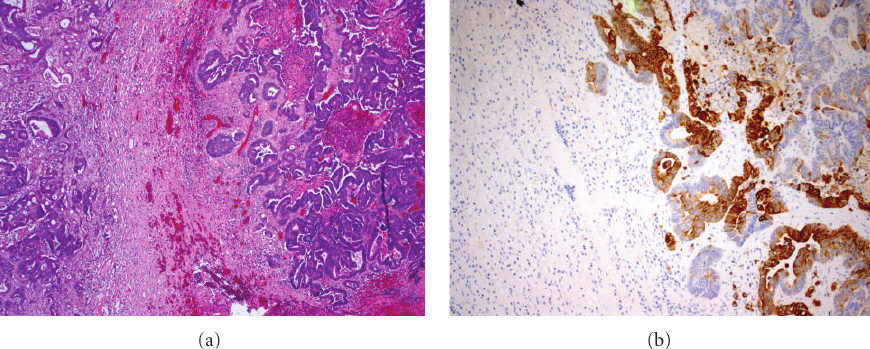
Figure 2: (a) Brain tissue infiltrated by an adenocarcinoma, original magnification × 40. (b) Immunohistochemical cytoplasmic stain for CK 20, a low-grade cytokeratin typical for colonic origin, original magnification ×